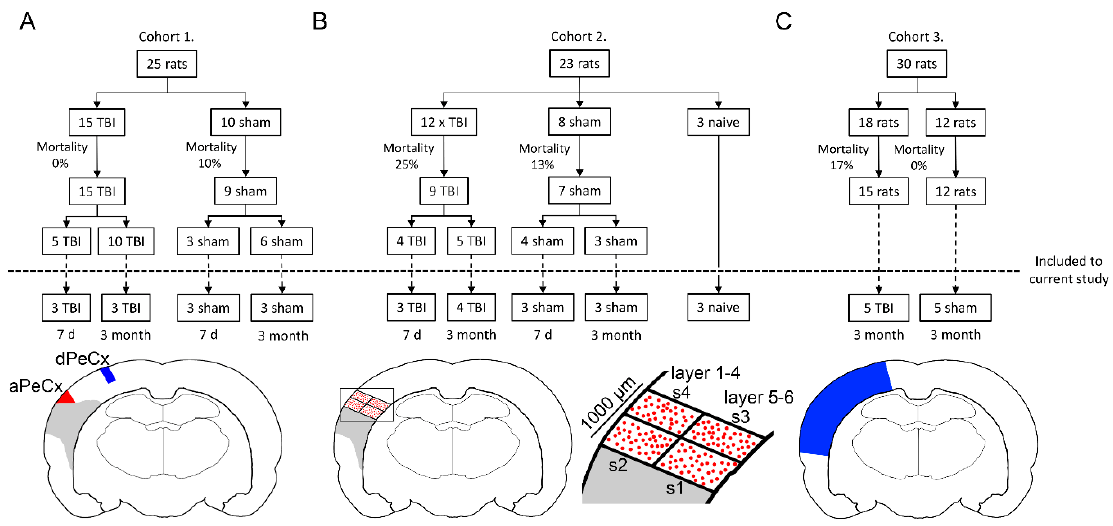
Figure 1. Study design and tissue sampling. ( A ) Cohort 1: a total of 25 animals underwent either traumatic brain injury (TBI; n = 15) or sham ( n = 10) operation. Of the surviving 24 animals, 8 (5 TBI, 3 sham) were killed at 7 d post-TBI, and the rest (10 TBI, 6 sham) at 3 months post-TBI. Six TBI and 6 sham animals were randomly chosen for RT-qPCR analysis. Two samples were dissected for analysis: the perilesional cortex adjacent to the lesion core (aPeCx, red) and the somatosensory cortex distal to the lesion (dPeCx, blue). ( B ) Cohort 2: a total of 23 animals underwent either TBI ( n = 12) or sham ( n = 8) operation. From the surviving 16 animals 8 (4 TBI, 4 sham) were killed at 7 d post-TBI, and the remaining animals (5 TBI, 3 sham) at 3 months post-TBI. Altogether 7 TBI and 6 sham rats were used for miR-124-3p in situ hybridization. The remaining 3 animals did not undergo any surgical procedures (naïve controls). Analysis of miR-124-3p expression in in situ-processed sections was conducted in individual cells (red dots) within a 1000- µ m thick sector adjacent to the lesion core. A corresponding area was analyzed in the control samples. ( C ) Cohort 3: a total of 30 animals underwent either TBI ( n = 18) or sham ( n = 12) operation. At 3 months post-TBI, animals were killed and the brain was cut into 2-mm thick coronal slices (bregma levels from − 2.2 to − 6.2) and tissue from the perilesional cortex (blue area in A) was sampled for RNA-sequencing.